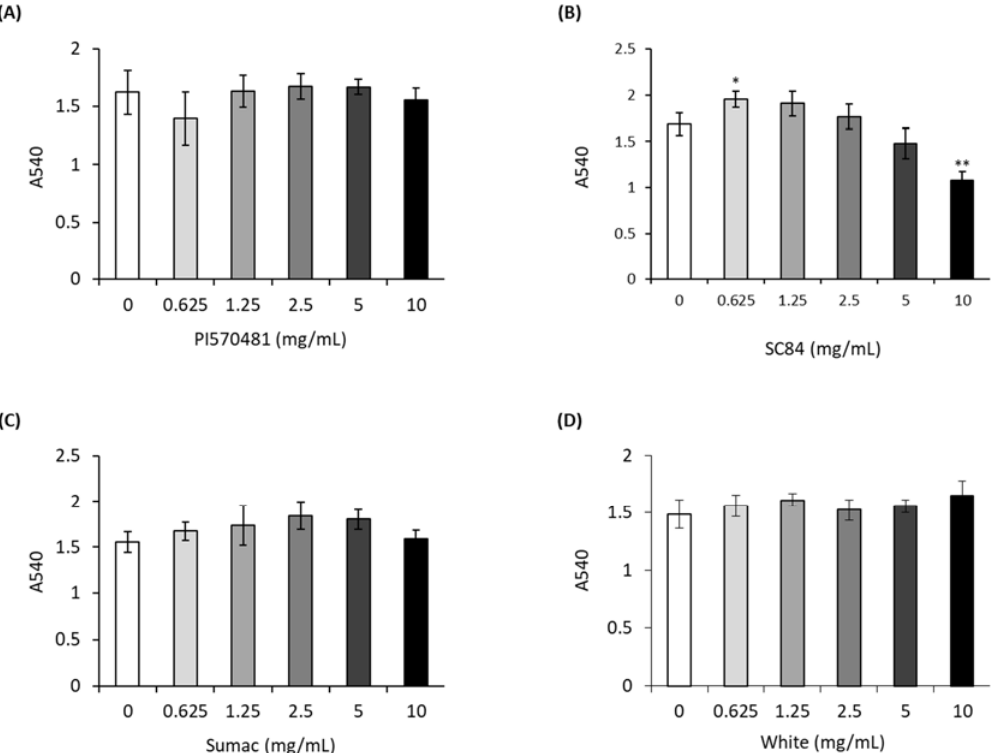
Figure 2. Sorghum bran extracts did not affect viability of 3T3 ‐ L1 cells. 3T3 ‐ L1 cells were treated with different doses of sorghum extracts (( A ) PI570481, ( B ) SC84, ( C ) Sumac, ( D ) white) for 24 h and MTT assay was performed to measure the cytotoxicity. Values are means ± SD ( n = 3). Significance is indicated as * p < 0.05, ** p < 0.01. Difference is between vehicle (0 mg/mL ‐ treated) and treatment group.